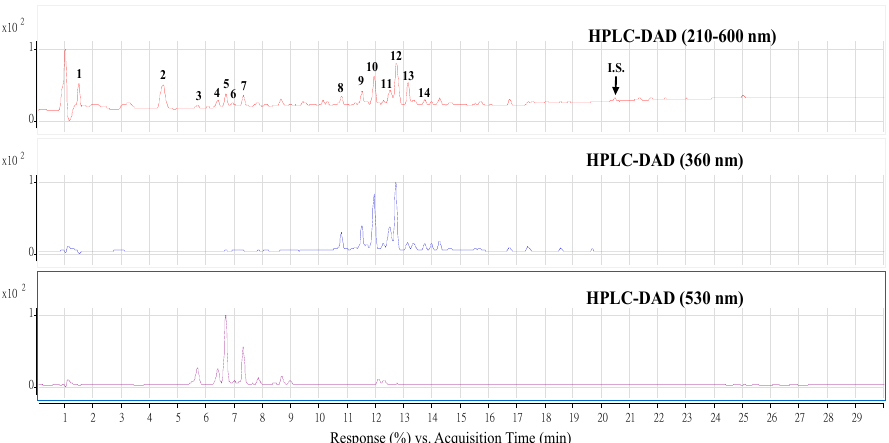
Figure 4. High performance liquid chromatograms detected at a full UV-Vis spectrum of 210–600 nm ( top ), UV 360 ( middle ), and 530 nm ( bottom ) from water extracts of djulis (WECF). Peak numbers refer to Table 1.